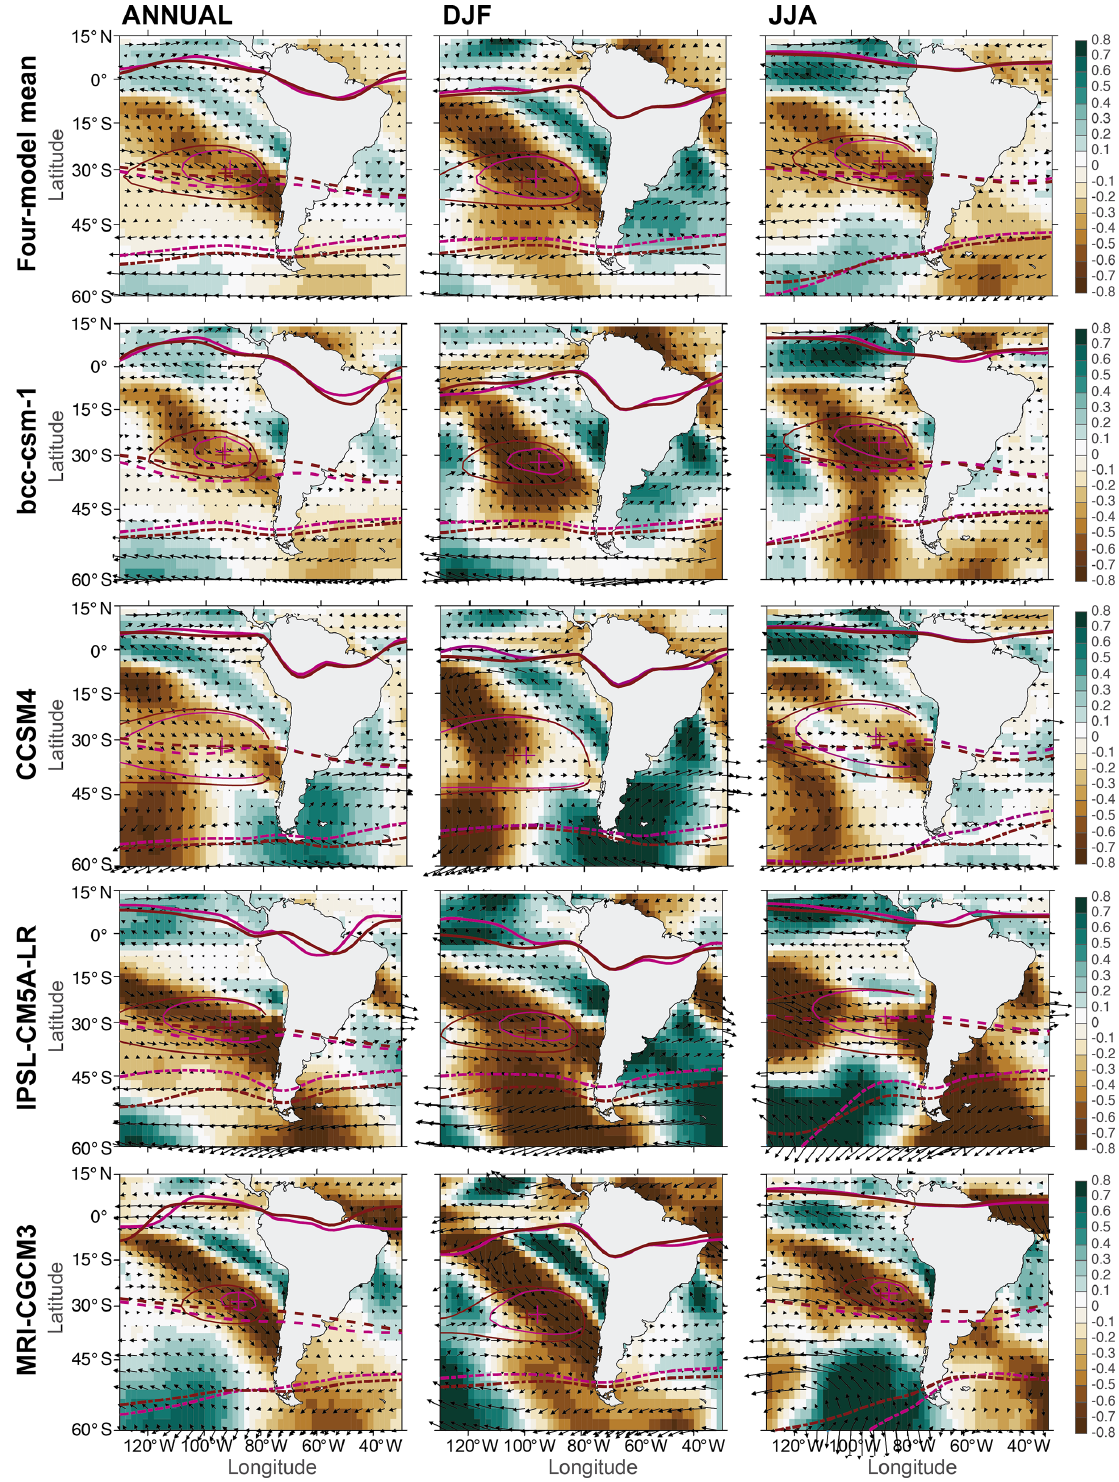
Figure 4. Annual and seasonal means of the southwestern South American climate system during the CWP (fuchsia lines) and 21C (dark red lines) for the four-model mean and for each model. Background colors and vectors show the meridional wind difference CWP minus 21C. DJF: austral summer, JJA: austral winter, ITCZ: Intertropical Convergence Zone (thick solid lines), SPSH: Subtropical South Pacific High (thin solid lines), STJ: subtropical jet (dashed lines), SWW: southern westerly winds (dash-dotted lines). Crosses indicate the location of maximum SLP over the SPSH (i.e., SPSH